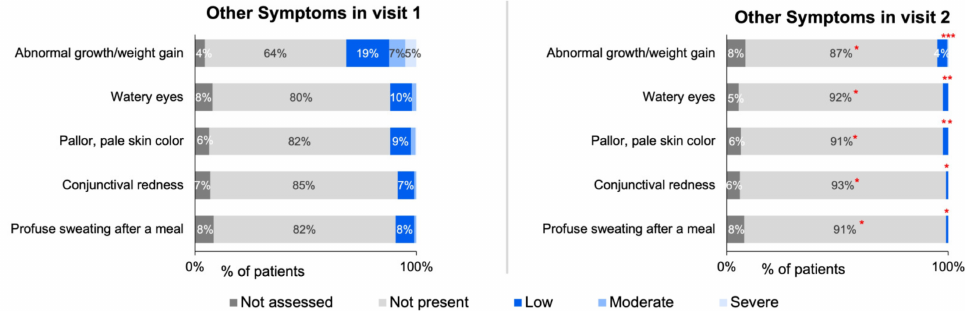
Figure 6. Distribution of other symptoms severity across initial and follow-up visits for infants ≤ 6 months of age with suspected or diagnosed CMPA. Note: ‘*’ denotes statistically significant symptom improvement between Visit 1 and Visit 2 (specific p -values listed in Figure